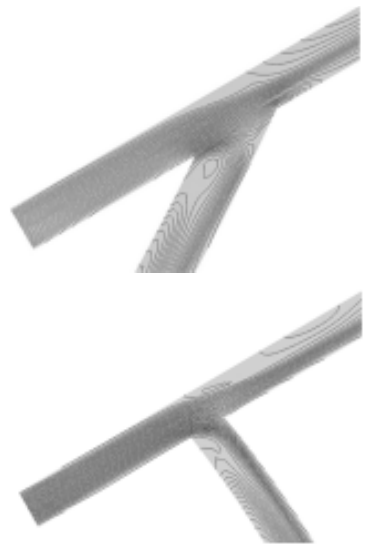
Fig. 10 - Lines of current for anastomosis of 30º and 90º. Near to the proximal anastomosis there is a region of low velocity and with recirculation, where the behavior of the flow in this region is favored by the greater angle of the